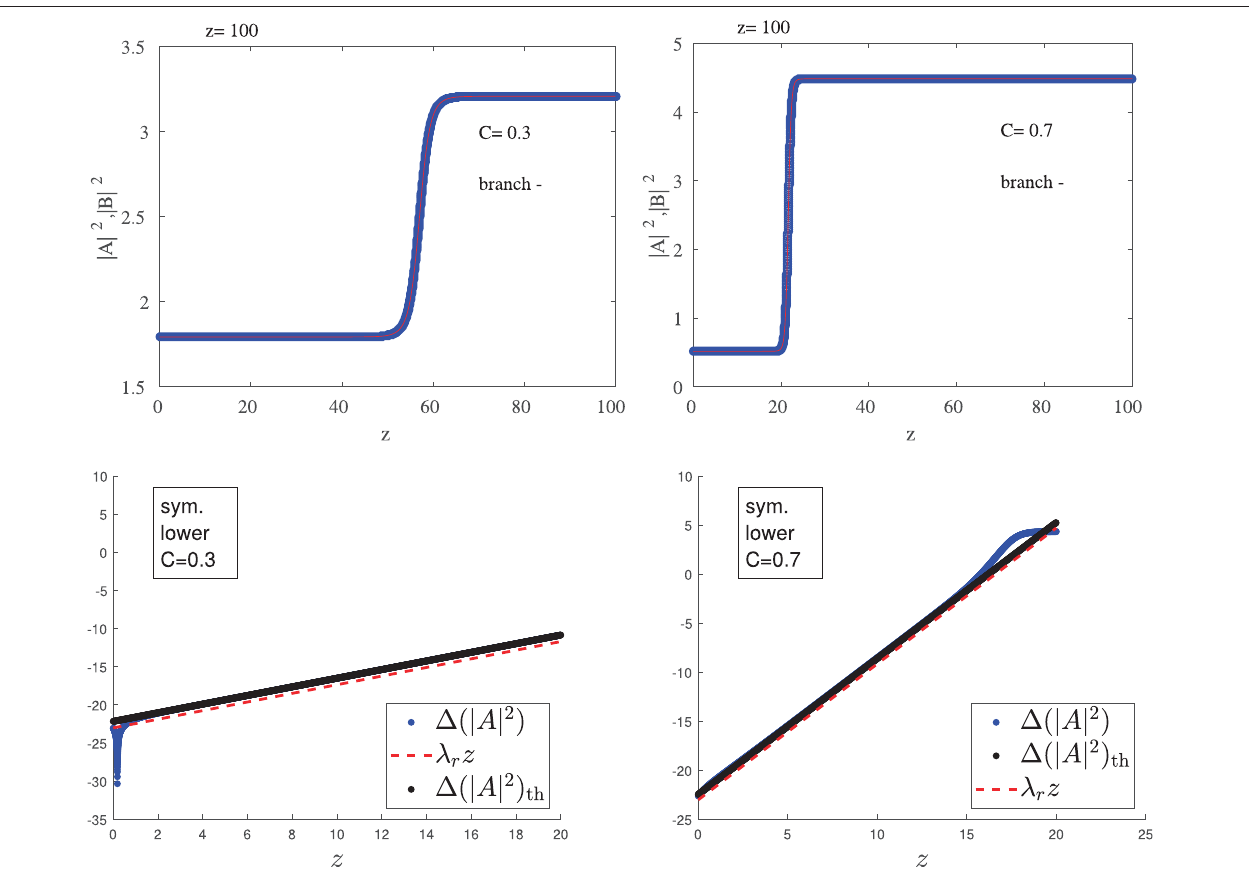
FIGURE8| Evolutionofsymmetric steady state solutionsfrom the lowerbranchin linear(top) and semilog (bottom) scale. The leftpanels are for C = 0.30and right onesfor C =0.70.Otherparametervaluesasinprevious fi gures.Itisclear(fromthetoppanels)thattheevolutiontendstothestablesymmetric(upperbranch)structures. Inthebottompanels,thedifferenceoftheamplitudefromthesteadystateamplitudeisshown,numerically(bluedots),andsemi-analyticallyviathepredictionofthelinear stabilityanalysis(blackdotswithsubscriptth).Thegrowthoftheexponentialinstability(linearinthesemilogplot)basedonthedominanteigenvalueisshownbythe red dashed line. See also the discussion in the